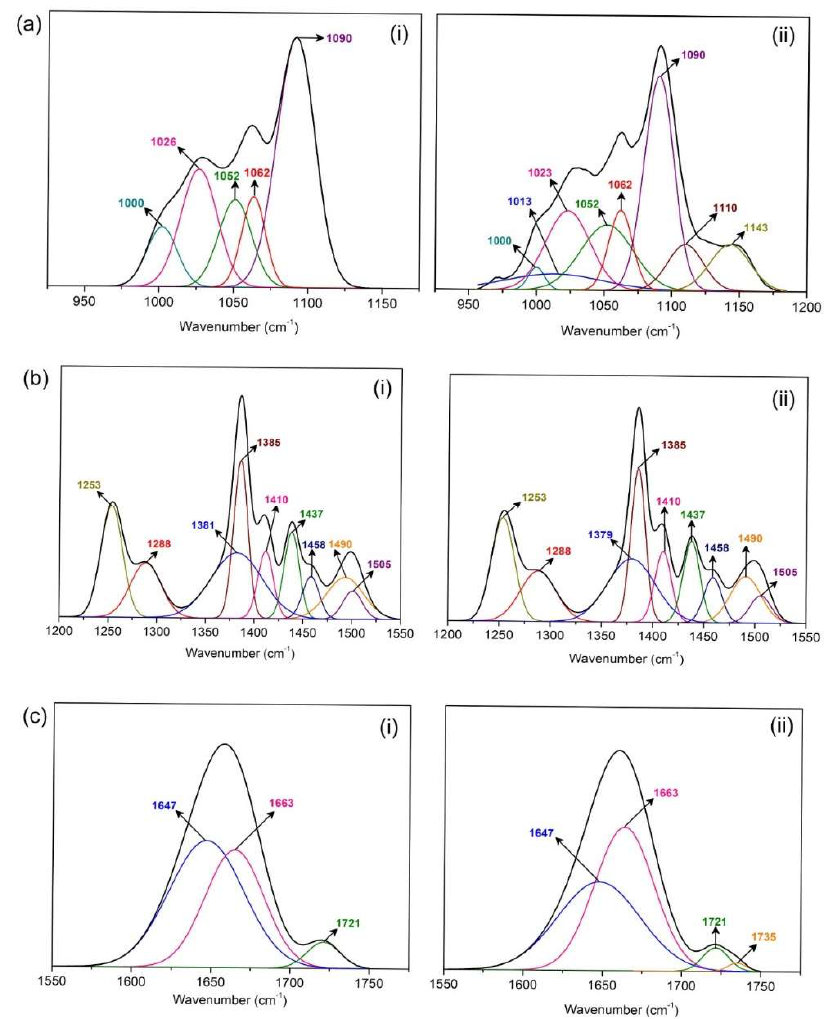
Figure 5. Deconvoluted FTIR spectra of PhSt-HEC-DMF with (i) LiI and (ii) TPAI gels in ( a ) ether, ( b ) amide and ( c ) carbonyl regions.